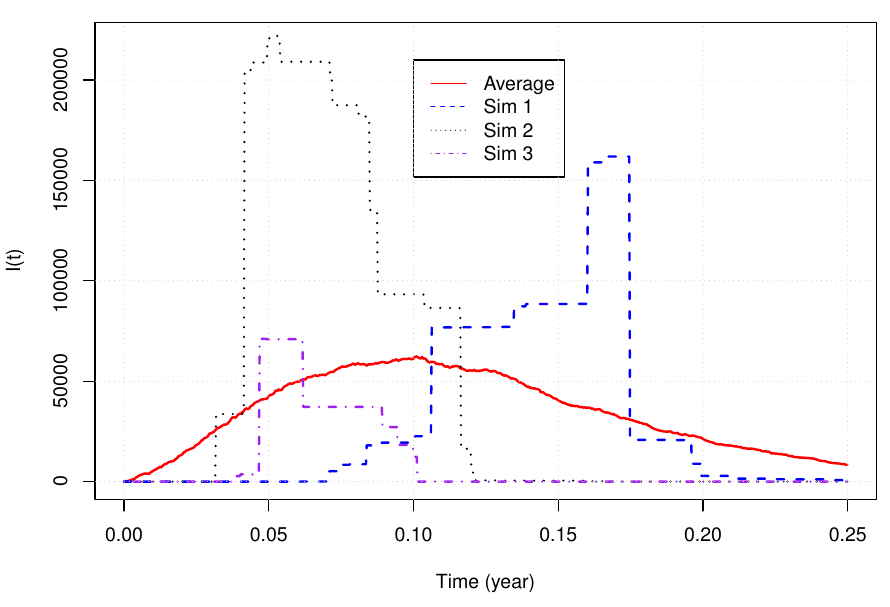
Figure 4. Simulation of three sample paths for I t and comparison with the simulated average of 1000 sample paths for